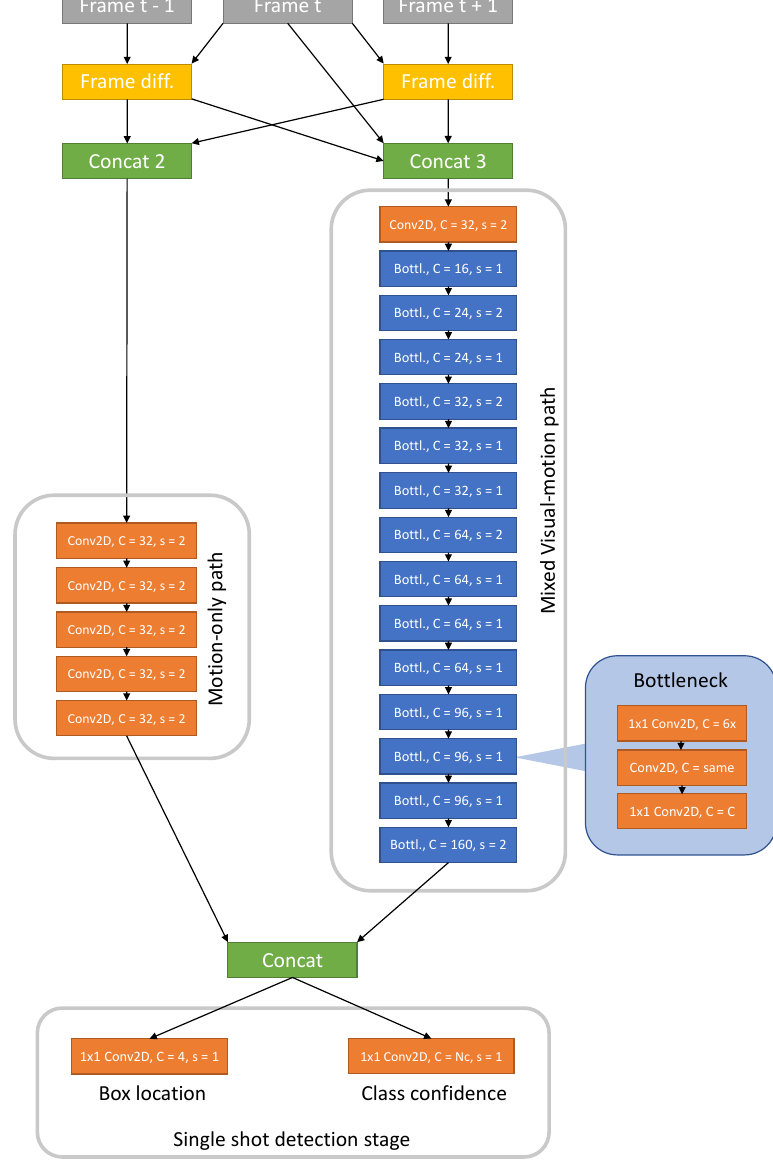
Figure 5. T-RexNet full architecture and image processing high level view. All the Conv2D blocks in the motion-only path use a 3 × 3 kernel. C is the number of output channels, s is the stride. Box locations are encoded with 4 numbers according to [7]. Bottleneck block [7] is highlighted: C = 6x means that the first block of the bottleneck is an expansion block which increments by a factor of 6 the number of channels; C = same means that the number of output channels is equal to the input ones; Nc is the number of